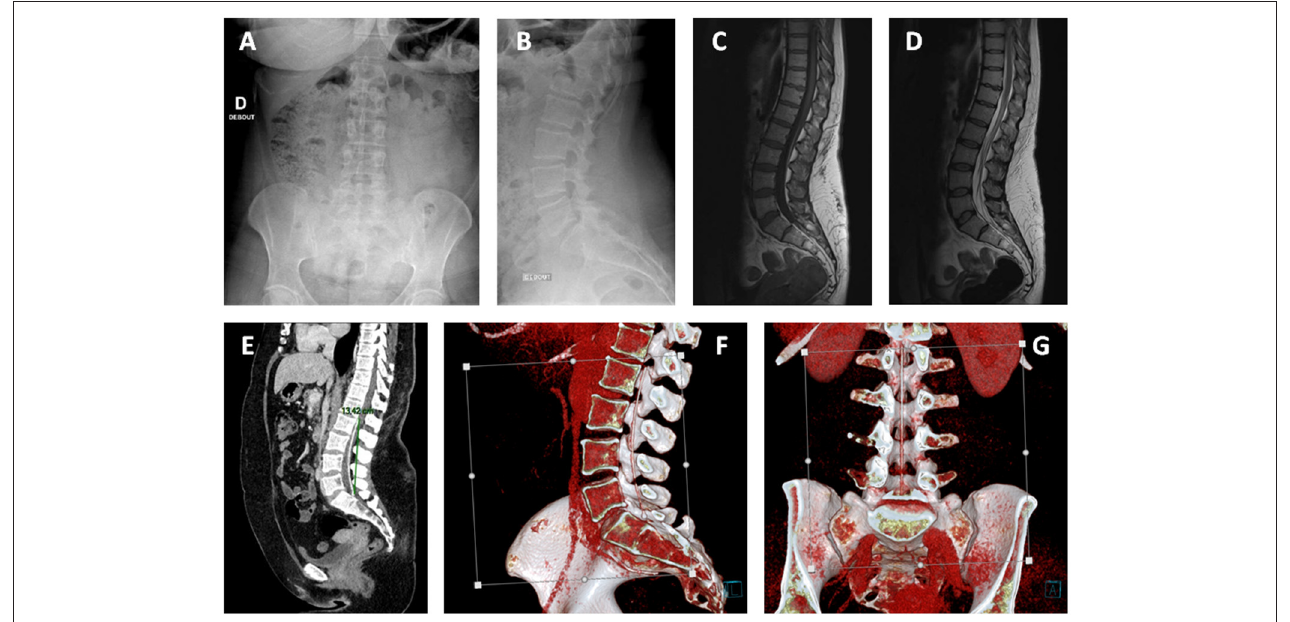
FIGURE 1 | Lumbar x-rays: anteroposterior (A) and lateral views (B) , MRI sagittal view, respectively, T1 (C) , and T2 (D) sequences. The presence of the catheter was hard to identify even for experienced radiologists, as its intensity on T1-weighted and T2-weighted images was similar to that of the cauda equina nerve roots. (E) Lumbar CT scanner sagittal view showing the initially placed fourth ventricle to cervical subarachnoid space shunt located at L2-S1 level measuring around 15cm in length and 2.5mm in diameter. (F,G) Three-dimensional (3D) reconstructions. There is no local compression of neurological elements.